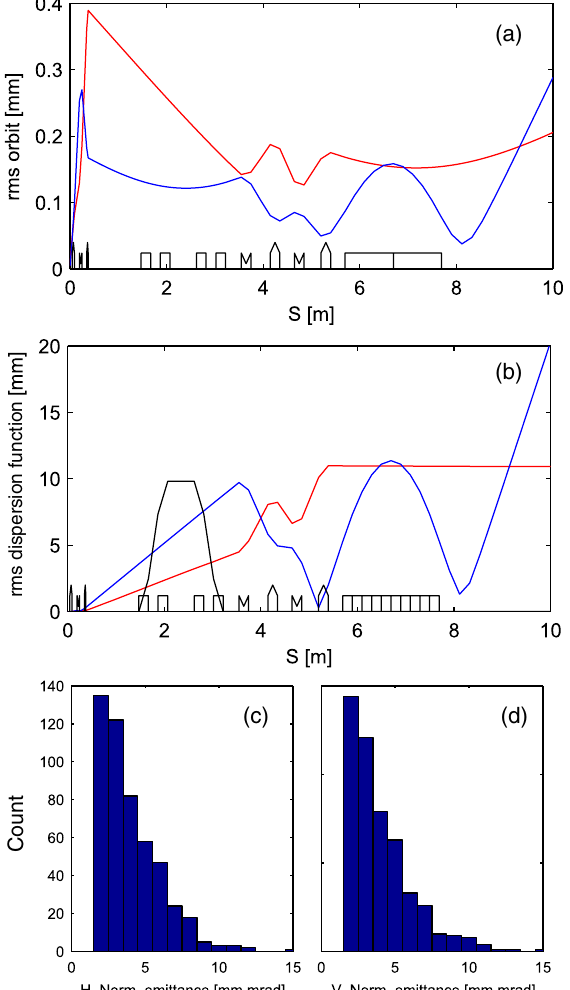
FIG. 9. Effect of random source jitters ( 5 μ m rms in transverse position, 1 mrad rms in divergence and 1% rms in energy spread) on the LPA beam quality. (a) Rms orbits in the (red) horizontal and (blue) vertical plane. (b) Dispersion functions in the (red) horizontal plane, (blue) vertical plane and (black) horizontal plane without jitter. (c – d) Statistical emittance distribution (500 tries) without the energy spread jitter, but with transverse position and divergence jitters ( 5 μ m rms in transverse position, 1 mrad rms in divergence) and including orbit corrections. Simulation in the nonlinear case with BETA and sympletic 6D tracking without collective effects using the S2I-CM optics with r 11 ¼ r 33 ¼ 10 and r 56 ¼ 0 . 4 mm.